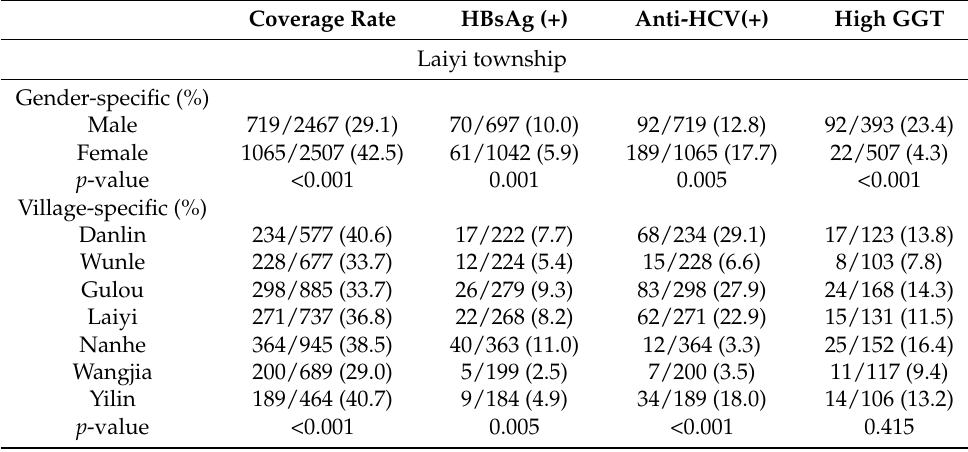
Table 2. Screen coverage rate and prevalence of hepatitis B virus surface antigen (HBsAg), antibody to hepatitis C virus (anti-HCV) and high gamma-glutamyl transferase (GGT) stratified by gender and